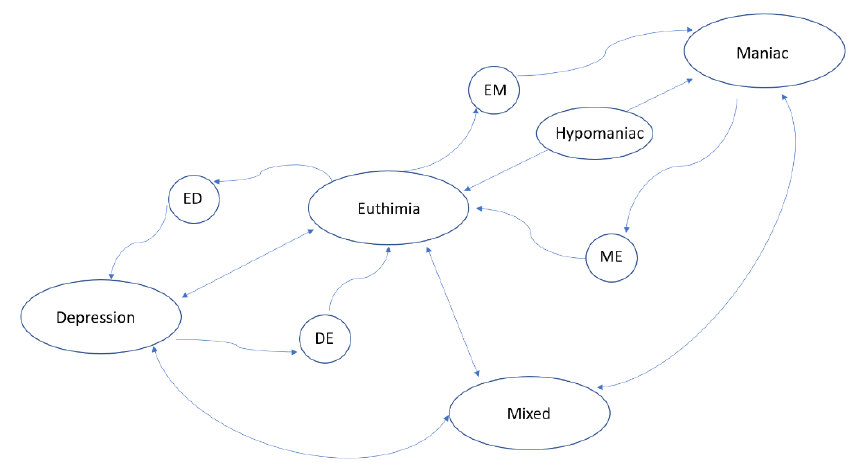
Figure 1. Transitional state-directed graph illustrating bipolar disorder phases (nodes represent the states and arrows represent the transition).